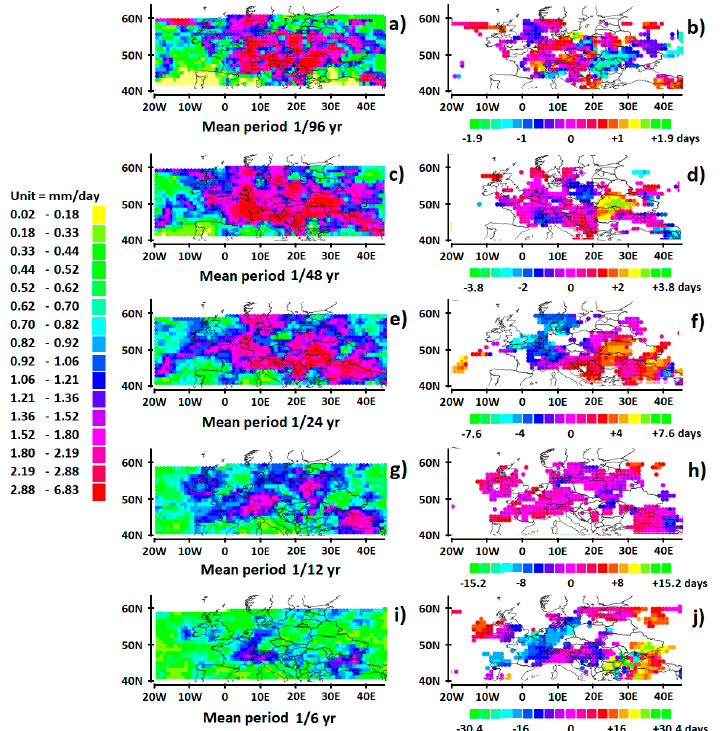
Figure 8. Same as Figure 3 for the amplitude ( a , c , e , g , i ) and the phase ( b , d , f , h , j ) of the harmonics of the precipitation height in western Europe. Time lags in ( b , d , f , h , j ) are expressed in relation to 14 July 2021. The time reference is the rainfall height in Germany at 47° N, 18° E. Daily precipitation data is provided by NOAA https://www.ncei.noaa.gov/data/global-precipitation-climatology-project-gpcp-daily/access/ (accessed 27 April 2022).